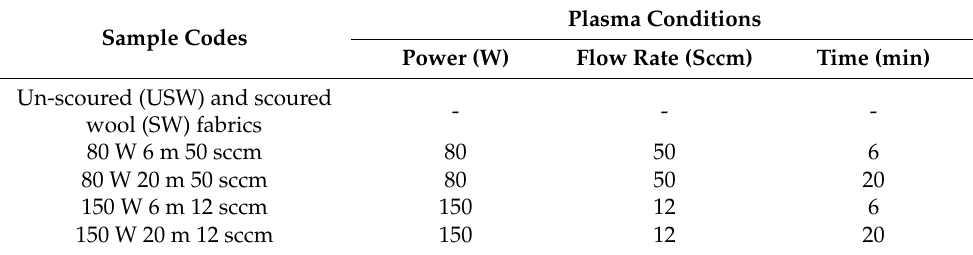
Table 2. Plasma treatment conditions of wool fabrics. Sample